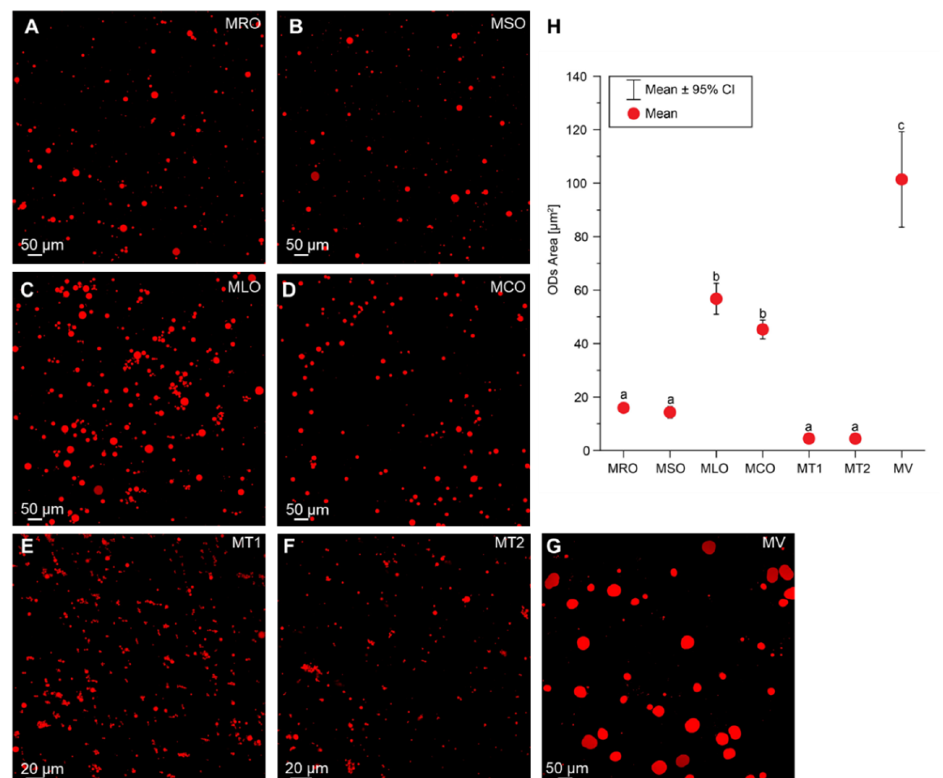
Figure 3. ( A – G ) Representative images of oil droplets (ODs) stained with Nile red. ( H ) The data point-box plot showing a mean area of ODs quantified with imaging software (ImageJ). A statistical analysis was performed by a one-way analysis of variance (ANOVA) with Tukey’s post hoc test ( p < 0.05). Different letters (a–c) indicate significant differences with p < 0.05 between aquafaba-based mayonnaises with blends of refined rapeseed oil and cold-pressed rapeseed oil (MRO), cold-pressed sunflower oil (MSO), cold-pressed linseed oil (MLO), and cold-pressed camelina oil (MCO); MT1—